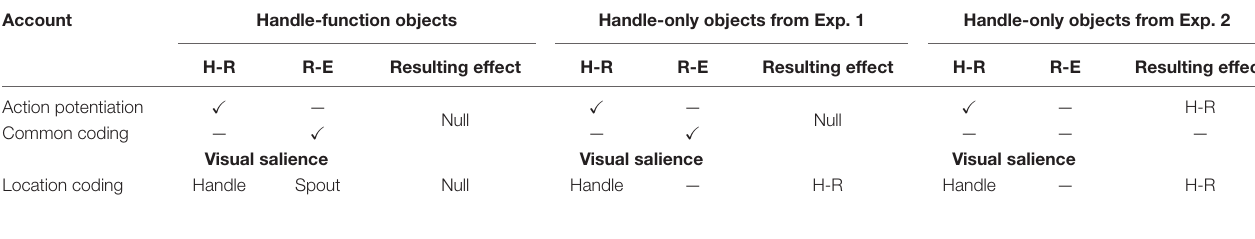
TABLE 2 | Summary table of the expected Handle-Response (HR) and Response-Effect (RE) compatibility effects for both handle-function and handle-only objects according to the action potentiation, common coding and location coding accounts.